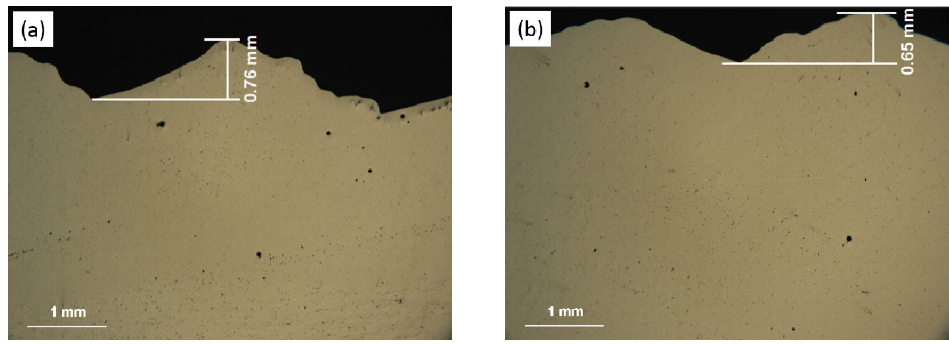
Figure 8. Longitudinal sections of WAAM components with the CMT ‐ ADV process. ( a ) TS = 0.6 m/min; ( b ) TS = 0.5 m/min.